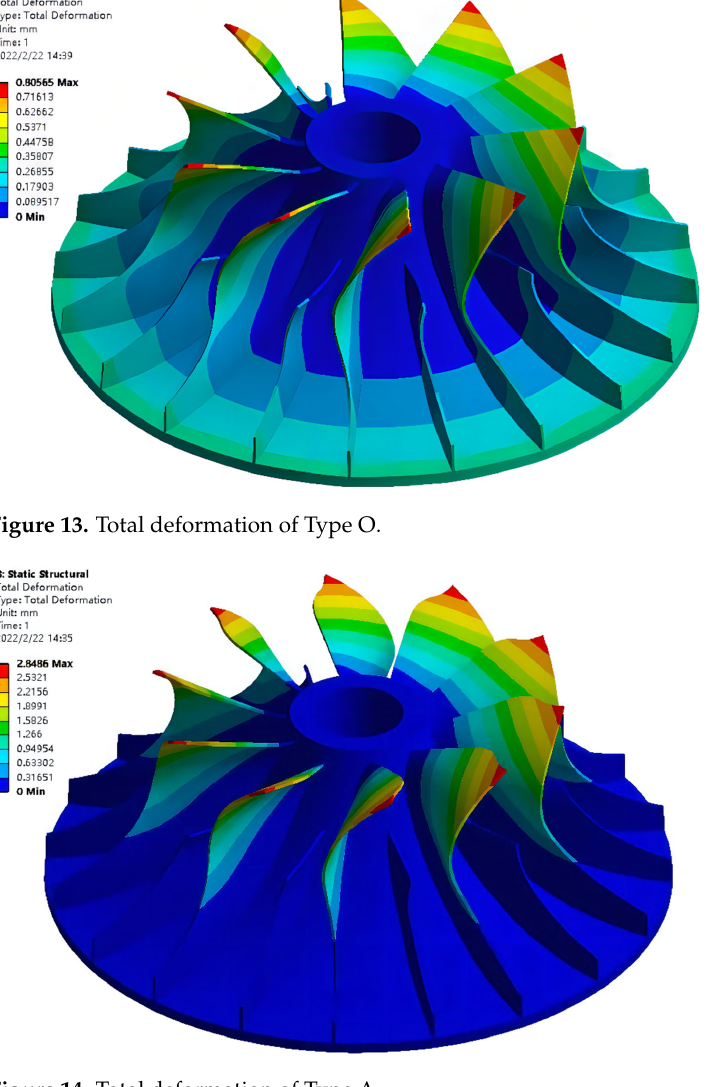
Figure 14. Total deformation of Type A.